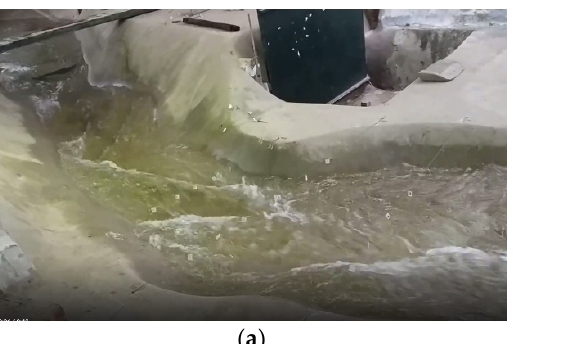
Figure 8. The coefficients plot of group 1 and Ialy hydropower plant.